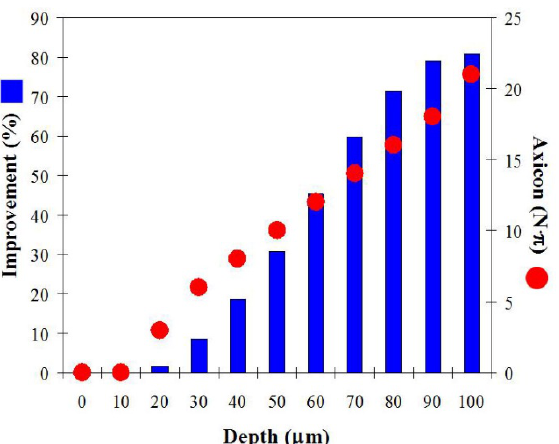
Figure 10. Improvement in TPEF signal as a function of depth using variable axicons. The results correspond to a piece of cellulose.